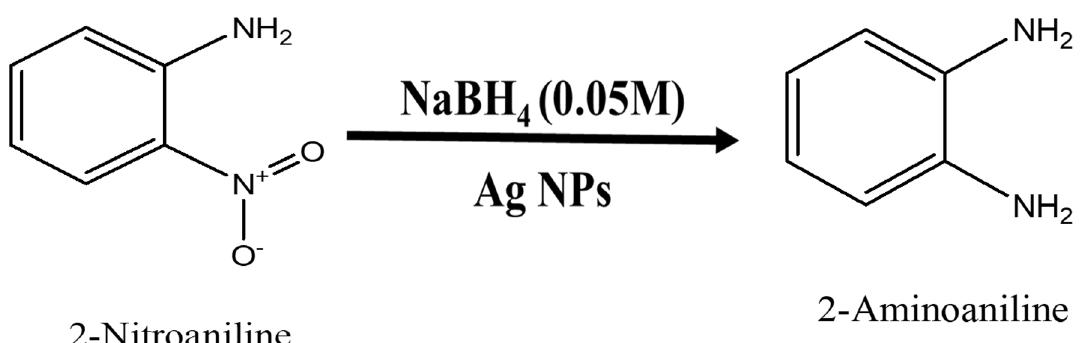
Figure 15. Schematic chemical reaction of conversion of 2-nitroaniline to